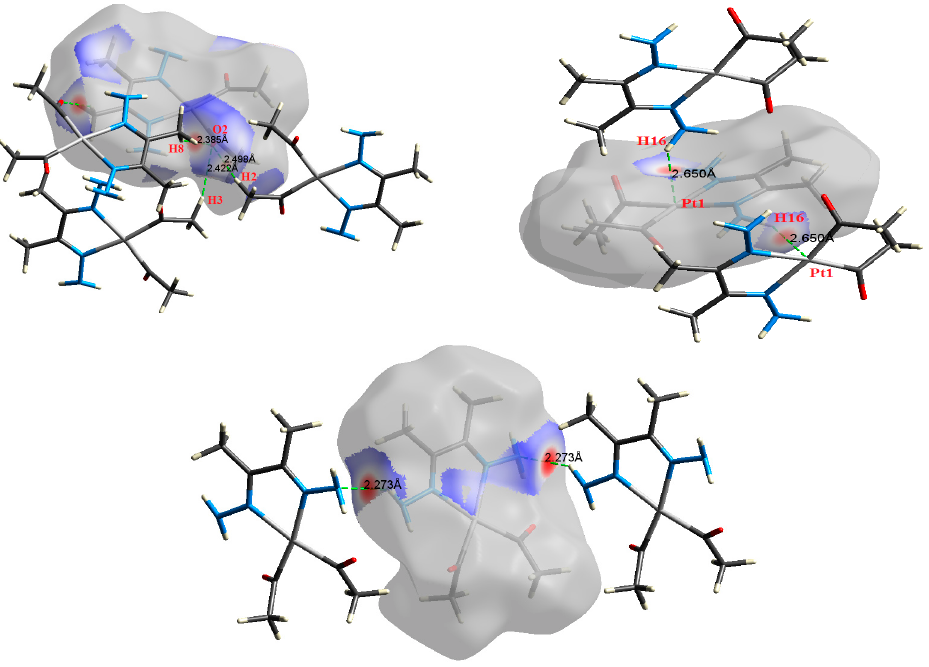
Figure 5. The most important intermolecular contacts in complex 3 .